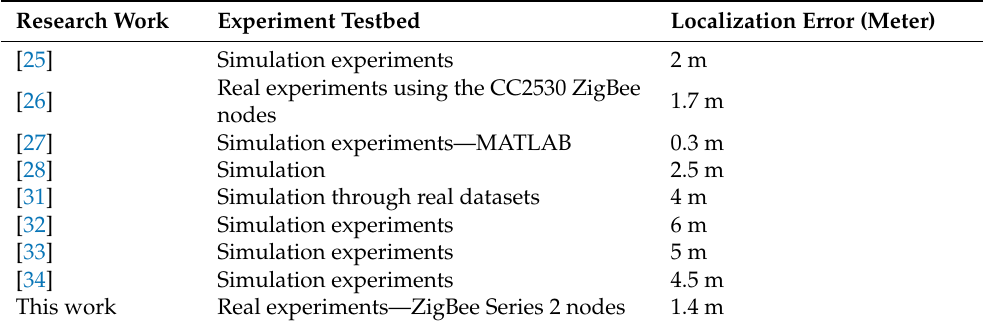
Table 12. A comparison between the developed fingerprinting localization approach and recent AI-based localization systems.